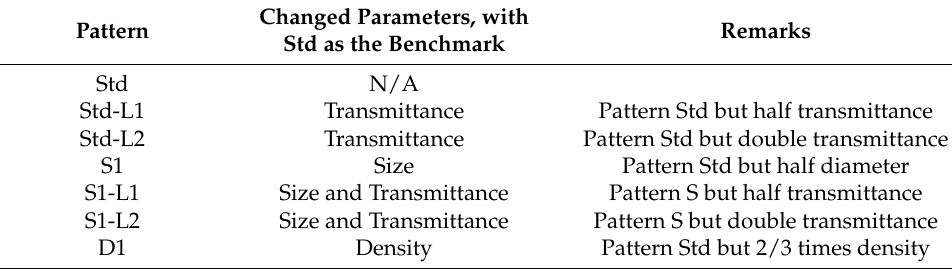
Table 1. List of experimental projection patterns.